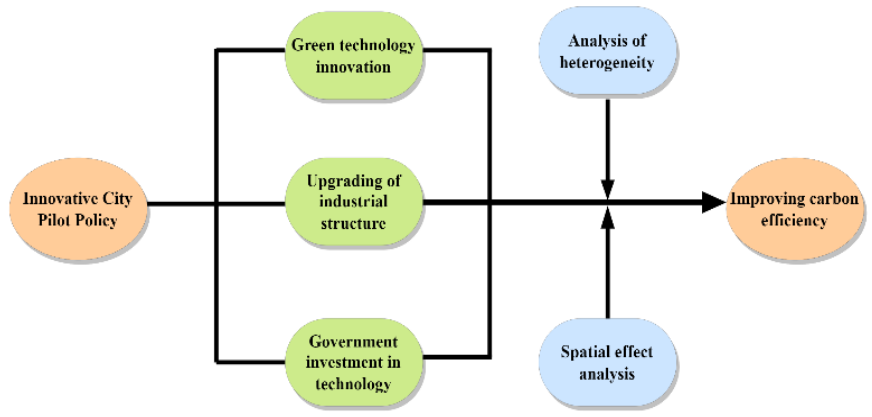
Figure 2. Mechanism analysis of the pilot policy to improve carbon efficiency.